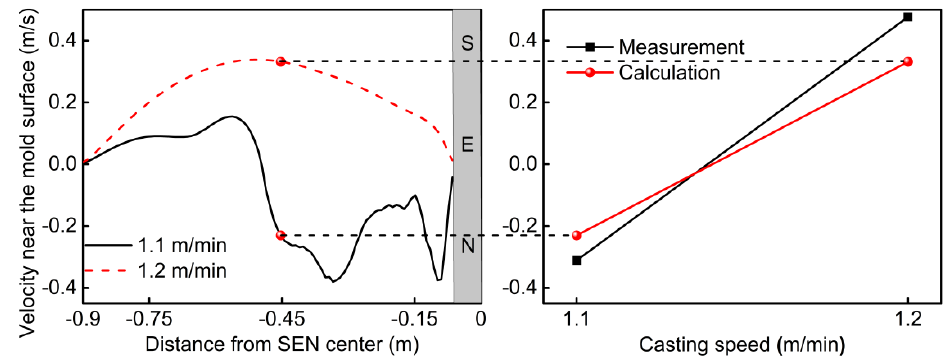
Figure 6. Comparison of the measured and calculated velocities near the mold surface at the dif- ferent casting